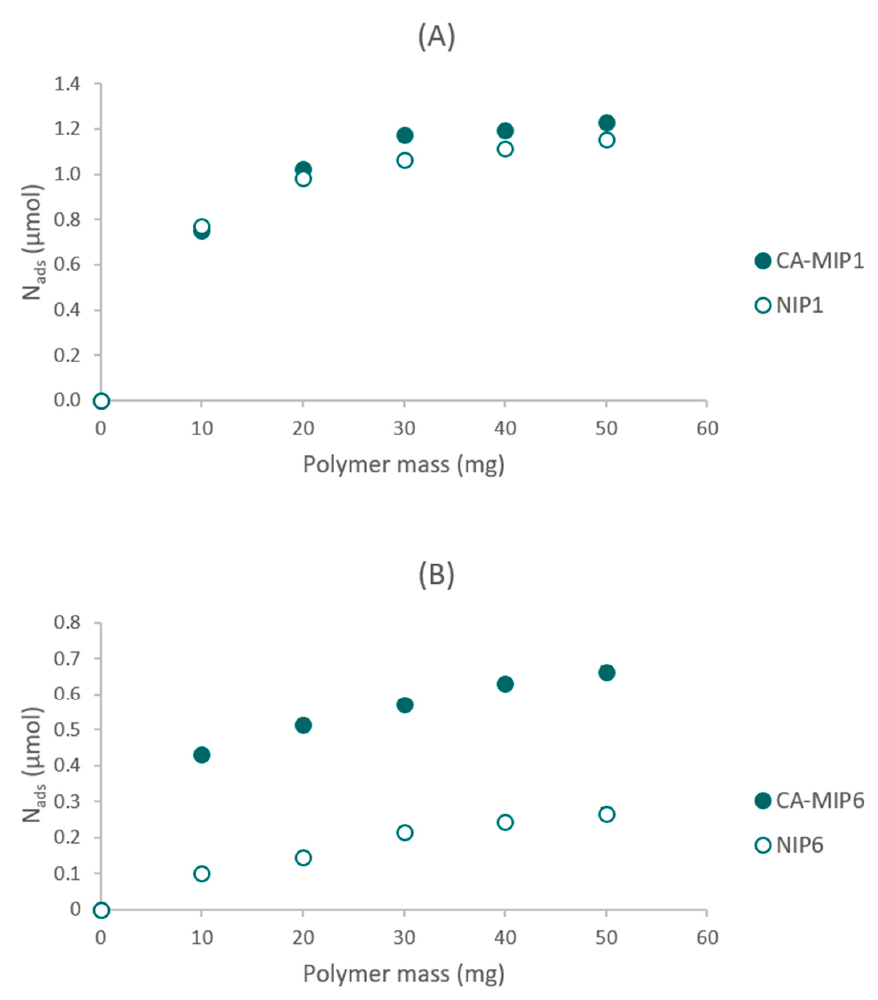
Figure 1. ( A ) Rebinding experiments of CA-MIP1/NIP1, ( B ) Rebinding experiments of CA- MIP6/NIP6.